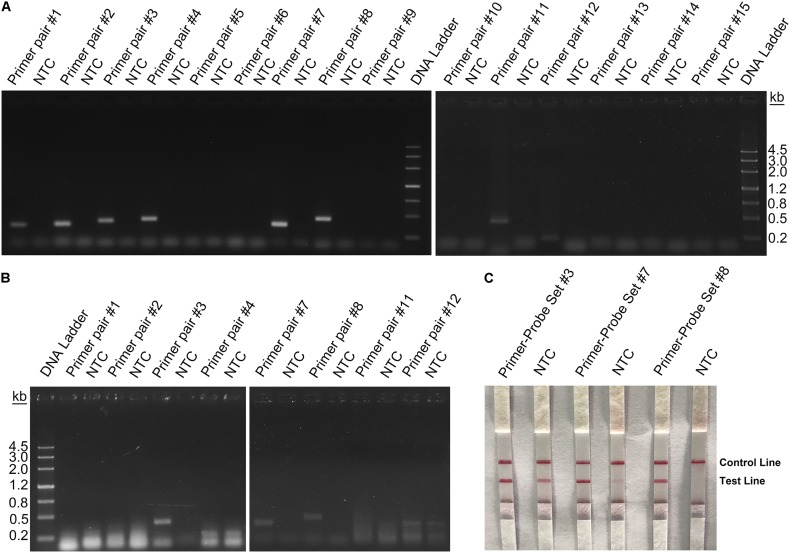
Screening of primers and probes. (A) Image of an agarose gel showing the PCR amplification of the primers using L. monocytogenes culture as the template. The primer pair name was indicated on top of each lane. The NTC lane immediately after is the no-template control of the respective primer pair. The band sizes of the DNA ladder are shown on the right. (B) Image of an agarose gel showing the RPA amplification of the primers using L. monocytogenes culture as the template. The primer pair name was indicated on top of each lane. The NTC lane immediately after is the no-template control of the respective primer pair. The band sizes of the DNA ladder are shown on the left. (C) The image shows that the LFS results of RPA amplifications with different primer–probe sets. The name of each primer–probe set is indicated on top of each strip. The NTC lanes are the no-template controls of the reactions. The positions of test and control lines are marked on the right of the strip image. The template was the L. monocytogenes culture. The reactions were performed at 40°C for 20 min.